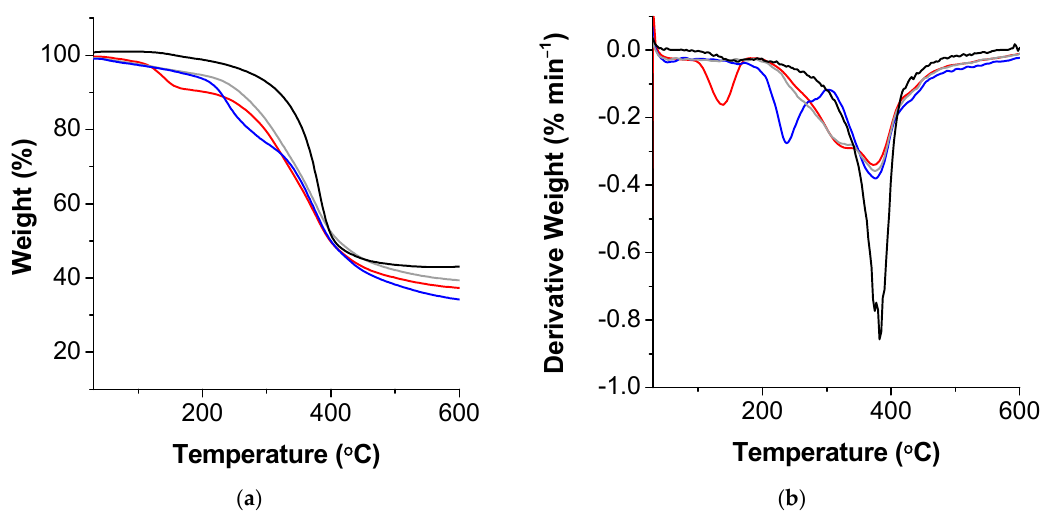
Figure 9. ( a ) Thermograms and ( b ) the corresponding differential thermograms (DTGs) of recovered lignin from extraction with formic acid (gray line), and 0.01 mol L − 1 of SDS (red line), CTAB (blue line), and PS20 (black line).